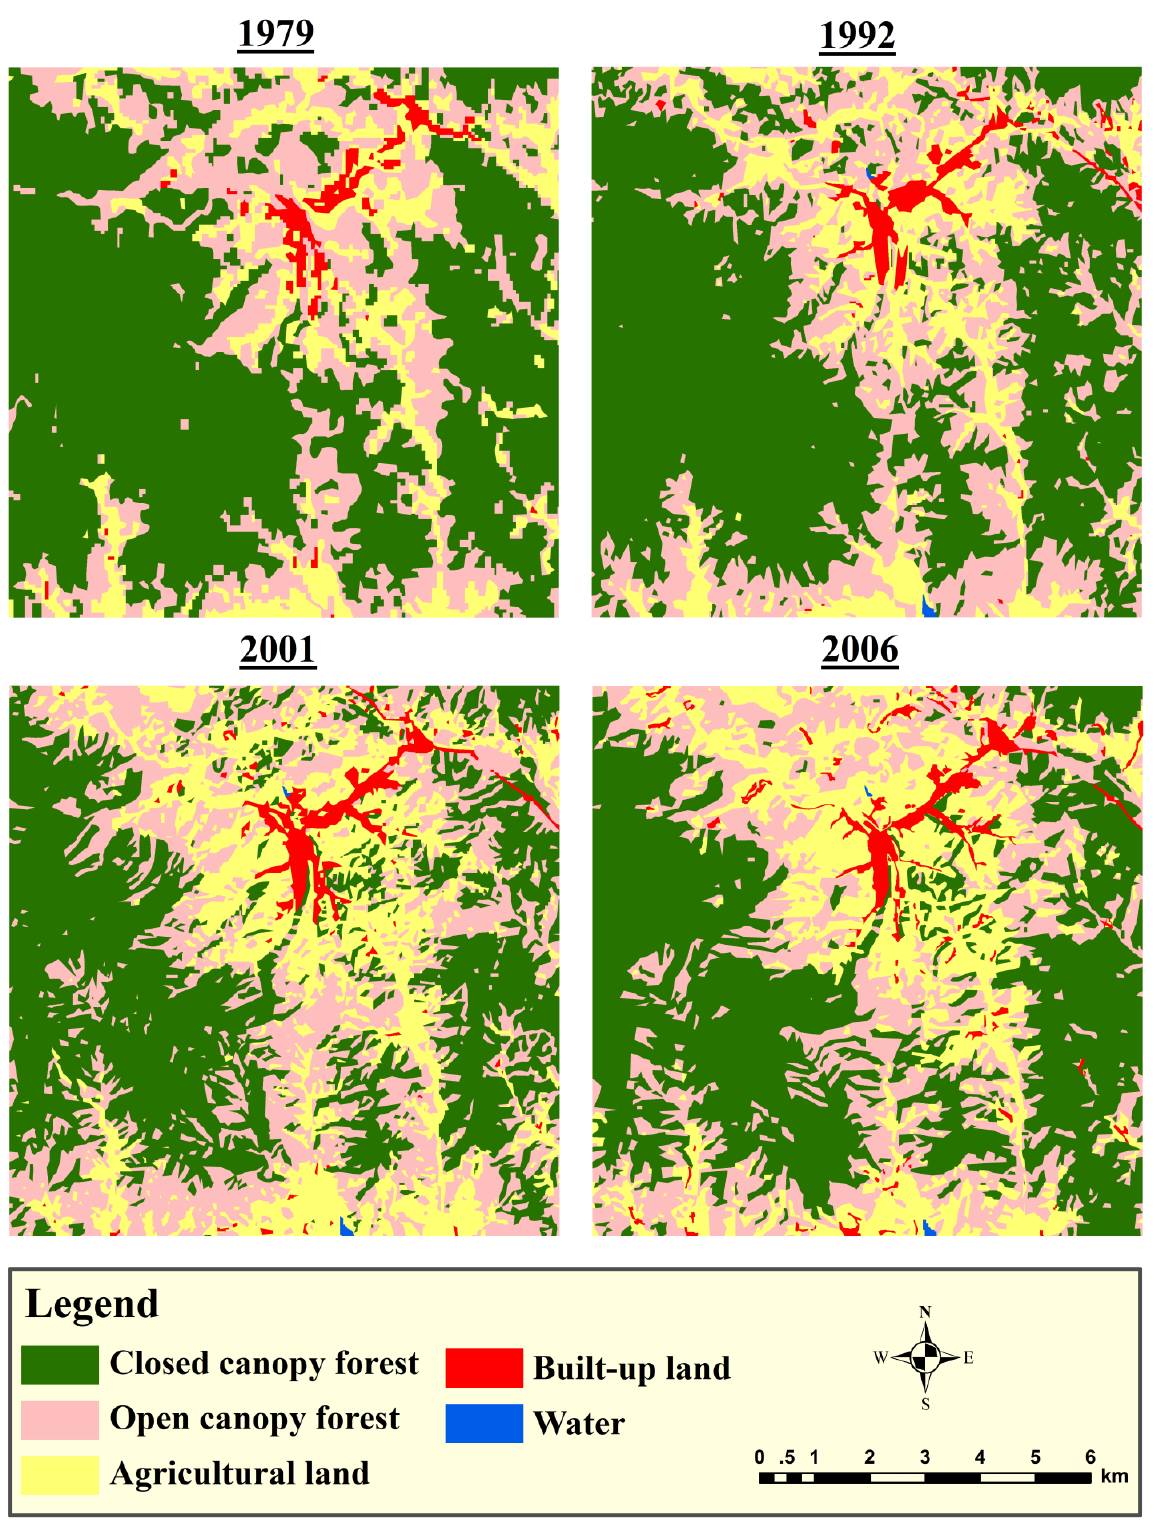
Figure 2. Land-cover maps for the years 1979, 1992, 2001 and